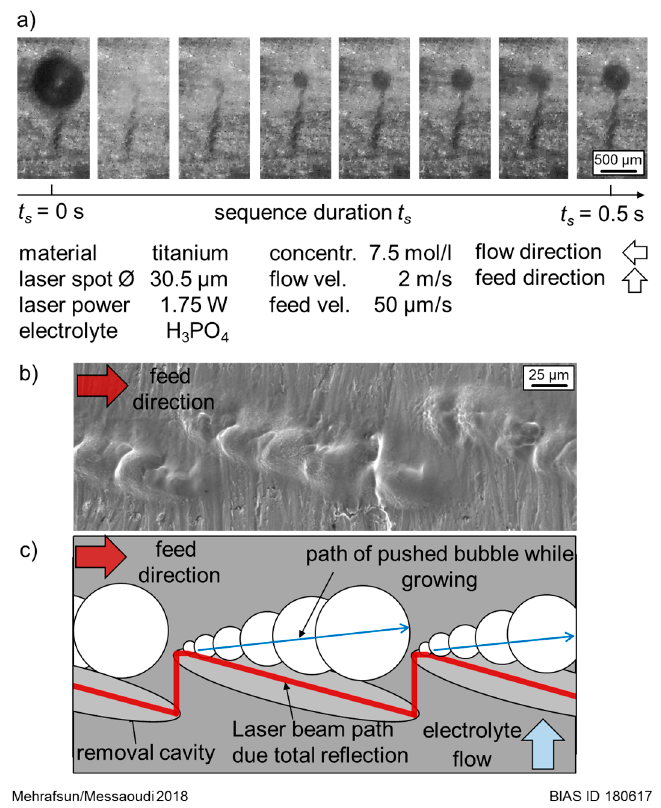
Figure 16. Removal disturbances due to total reflection of laser light by adhering and growing gas bubble; ( a ) CCD snapshots of gas bubble formation and growing during LCM of titanium in a 7.5-molar H 3 PO 4 solution at a laser power of 1.75 W and a feed velocity of 50 μ m/s; ( b ) SEM image of the resulting removal geometry as well as ( c ) a schematic illustration of the corresponding mechanisms.